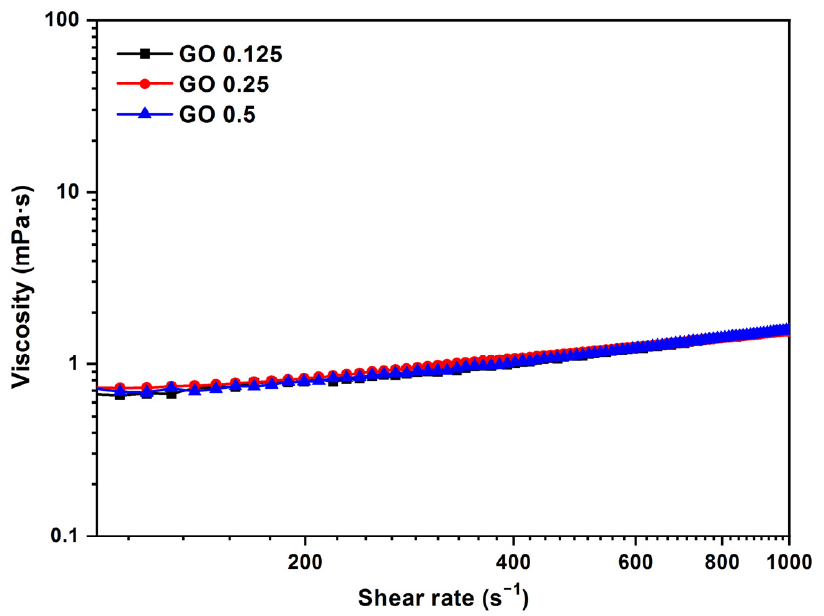
. γ Figure 6. Viscosity ( η ) vs. shear rate ( ) for different concentrations of GO (0.125, 0.25, and Figure 6. Viscosity ( η ) vs. shear rate ( γ(cid:4662) ) for different concentrations of GO (0.125, 0.25, and 0.5 0.5 mg/mL). Temperature: 37 ◦ mg/mL). Temperature: 37 °C.